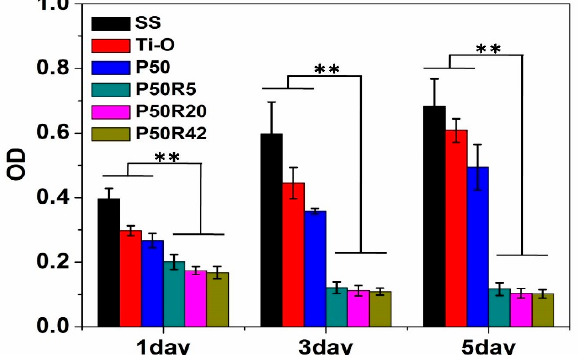
Figure 8. SMC attachment and proliferation cultured on the surfaces of SS, Ti–O, P50, P50R5, P50R20, and P50R42 using MTT (3-(4,5-dimethylthiazol-2-yl)-2,5-diphenyl tetrazolium bromide) assay (** p < 0.01).